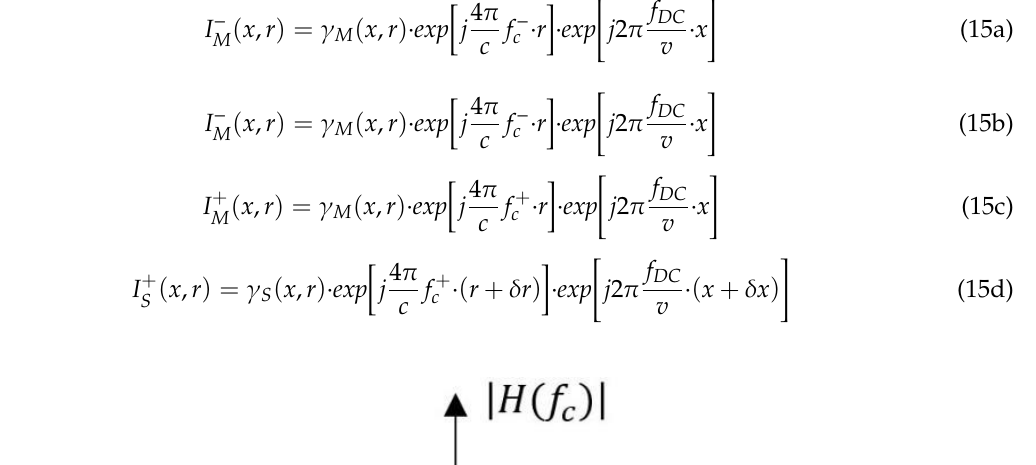
e ff ects. Perfectly aligned SAR data are then used to infer geophysical displacement measurements,